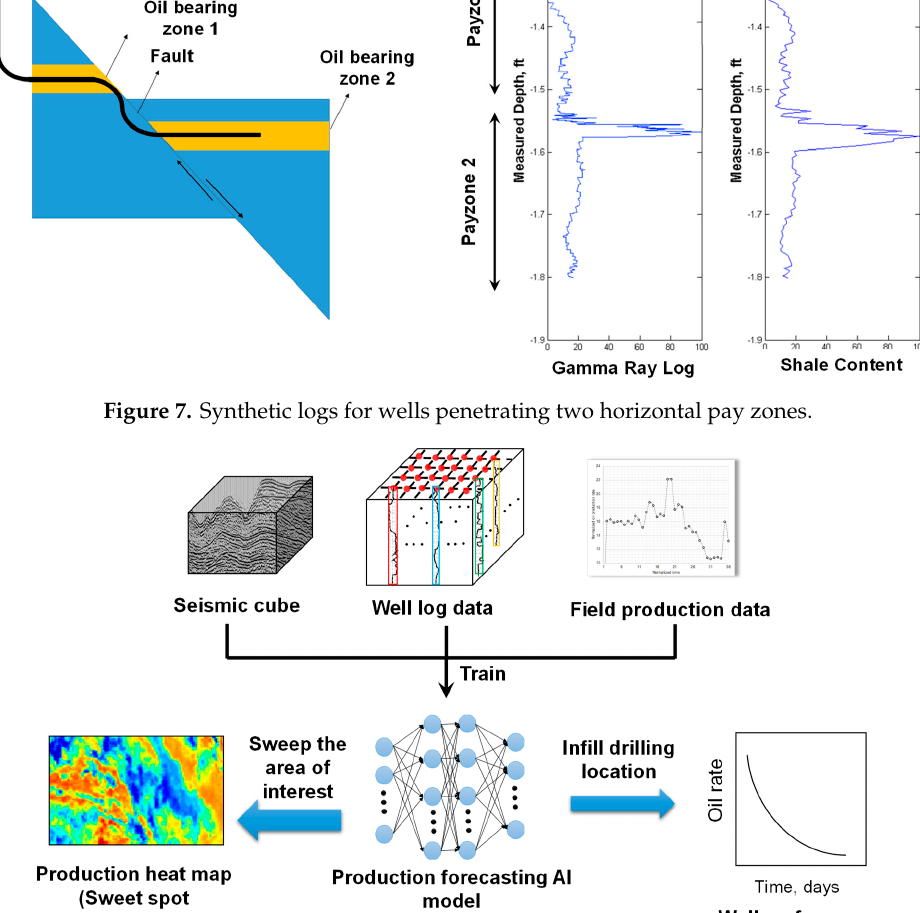
Figure 7. Synthetic logs for wells penetrating two horizontal pay zones.